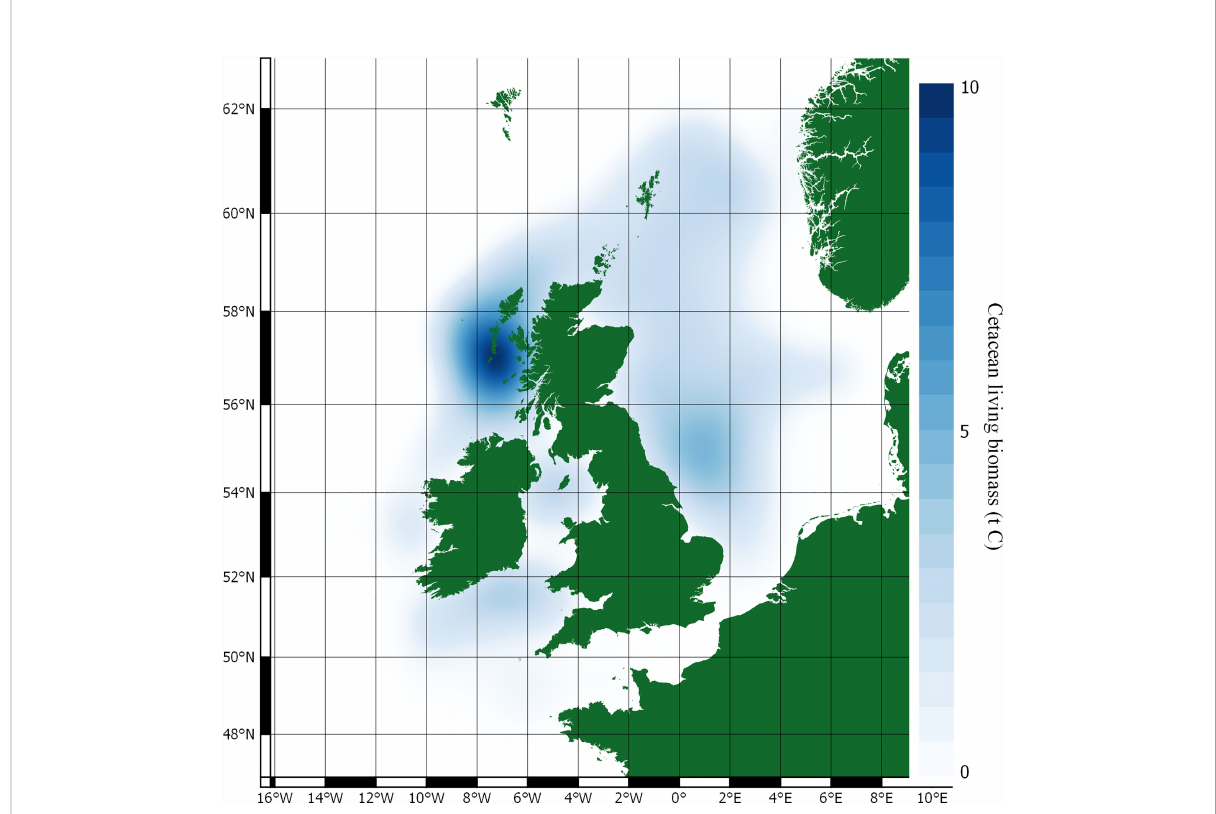
FIGURE 3 Carbon stocks in cetacean living